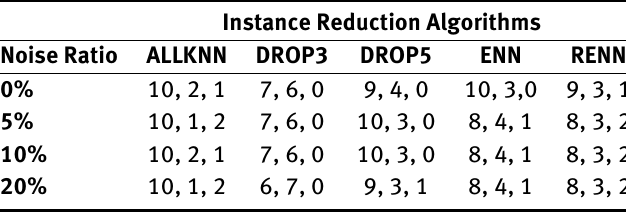
Table 12: Total Number of datasets with affected average Tree Size (++, unknown, –) for unpruned trees at different noise ratios